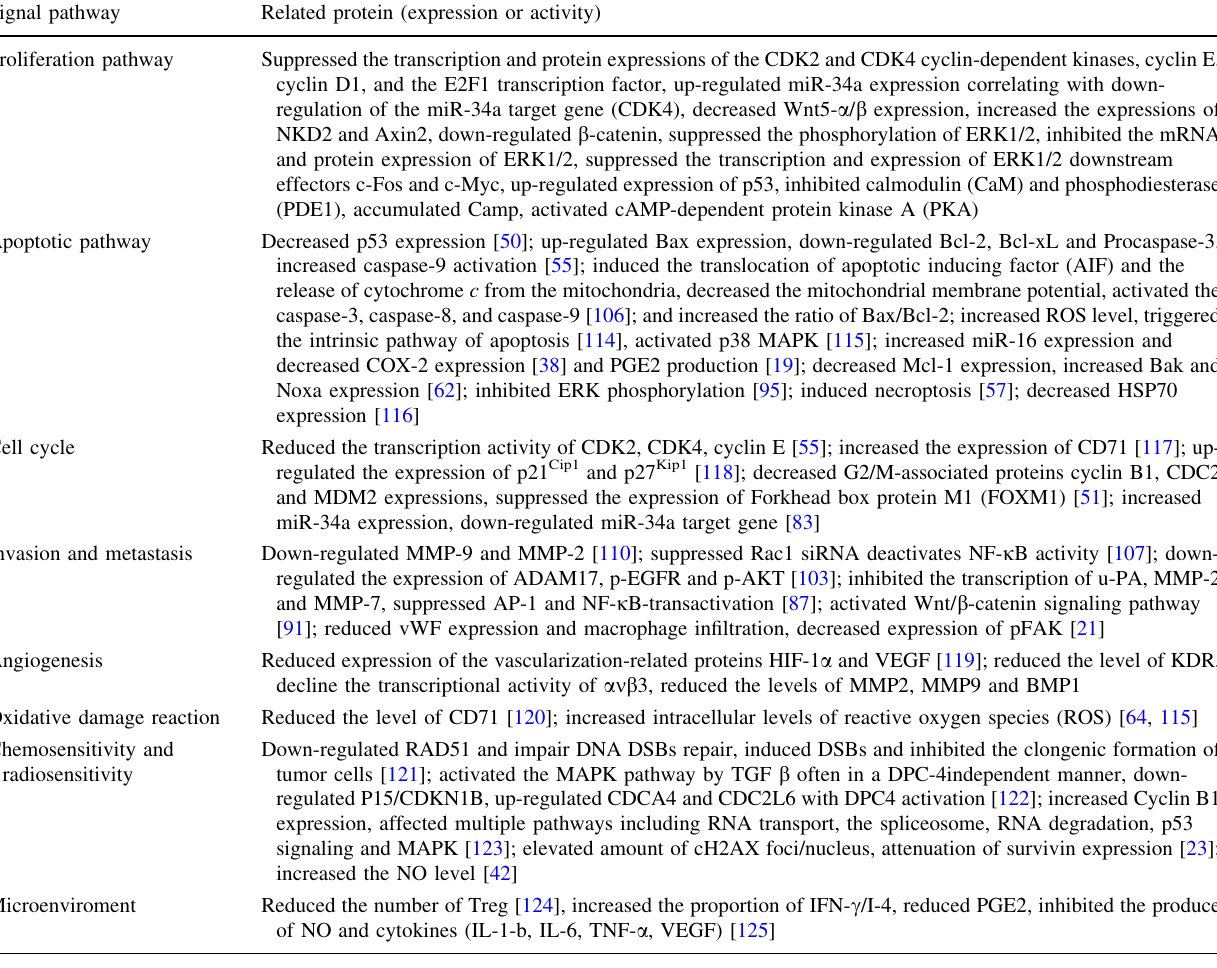
Table 8 The cell process and signal pathway regulated by artemisinins Signal pathway Related protein (expression or activity) Proliferation